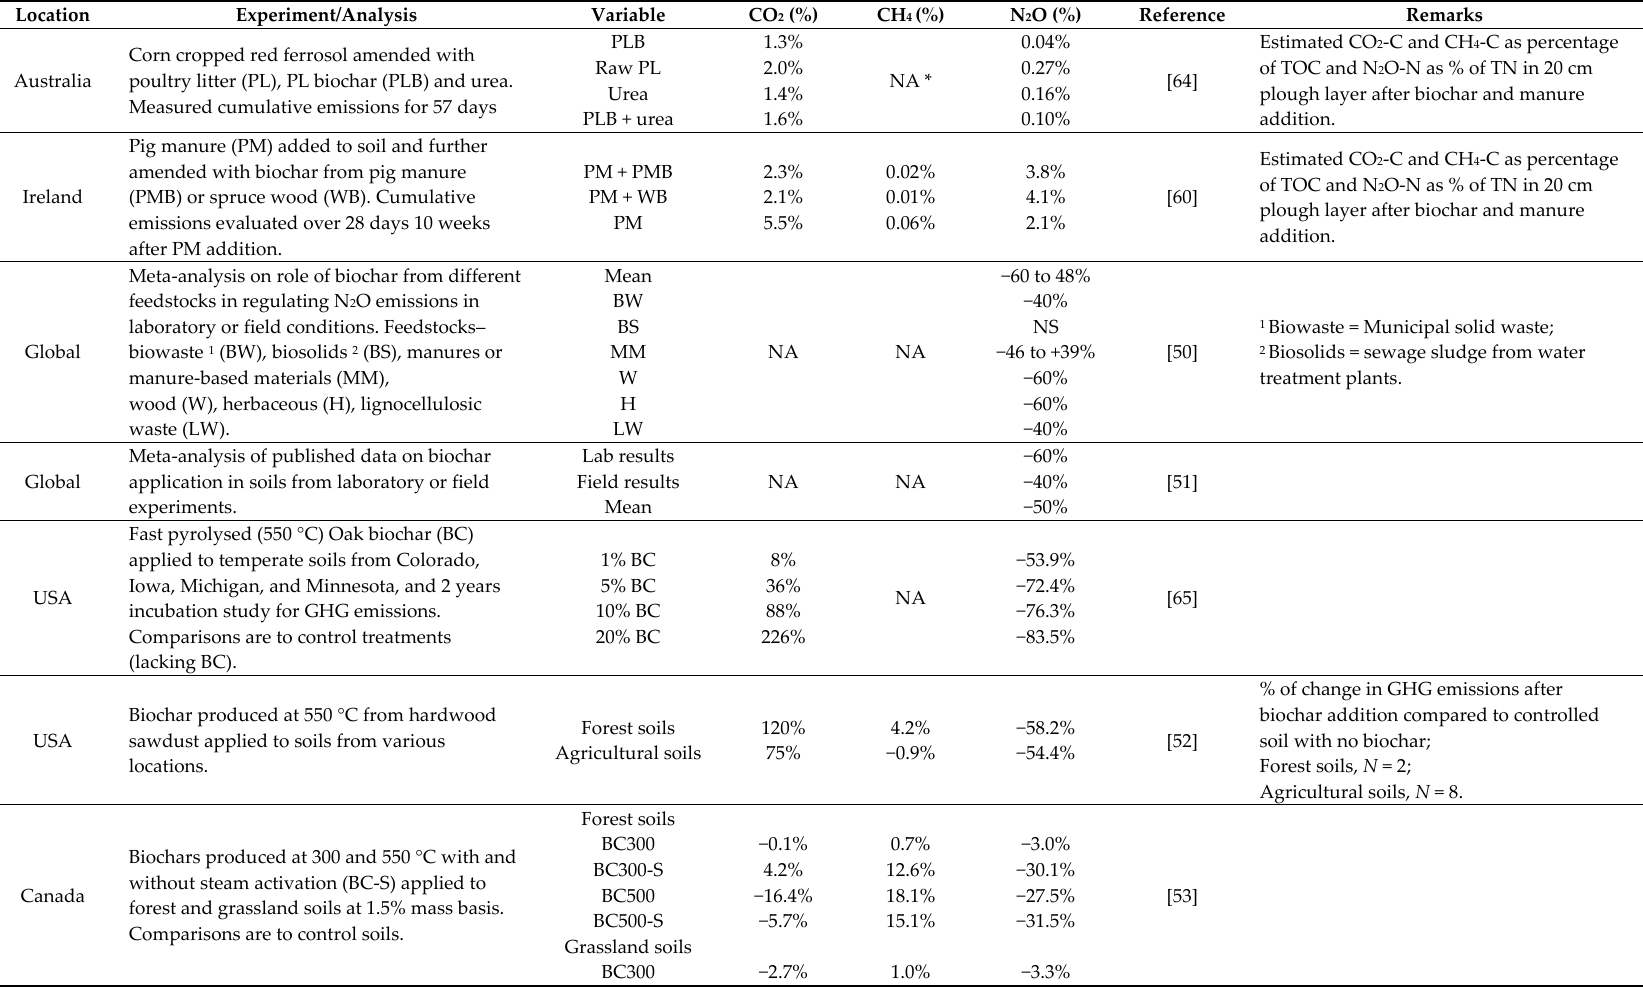
Table 2. Review of previous studies examining the effects of biochar and/or compost manure addition on relative changes in GHG emissions. Negative value shows reduction in GHG emissions.